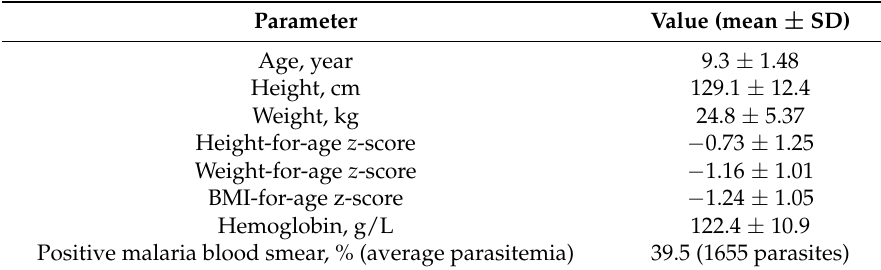
Table 1. Subject